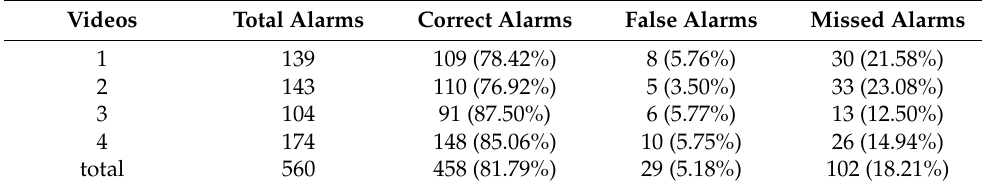
Table 6. Statistics of monitoring results of IR videos.